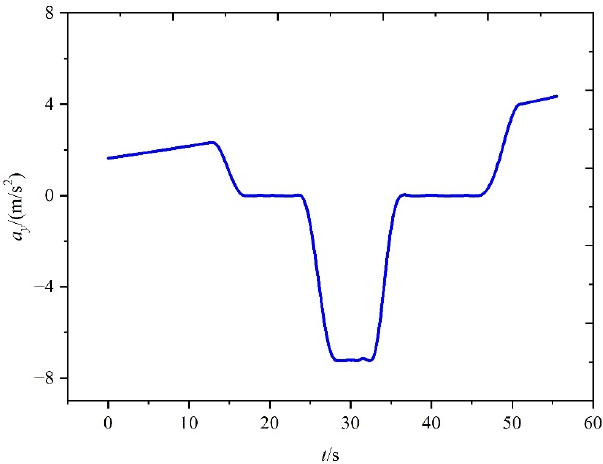
Figure 6. Vertical acceleration in the first scenario vs. time.